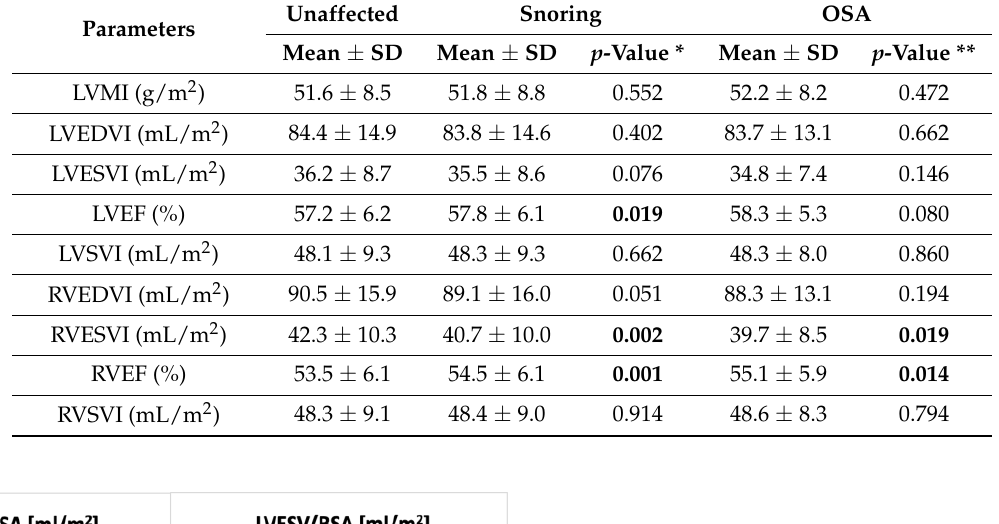
Table 3. Descriptive statistics of left and right ventricular cardiac parameters snoring vs. unaffected * and OSA vs. unaffected ** in male participants. Significant results are marked in bold. Reported values are left ventricular mass index (LVMI), end-diastolic volume index (LVEDVI), end-systolic